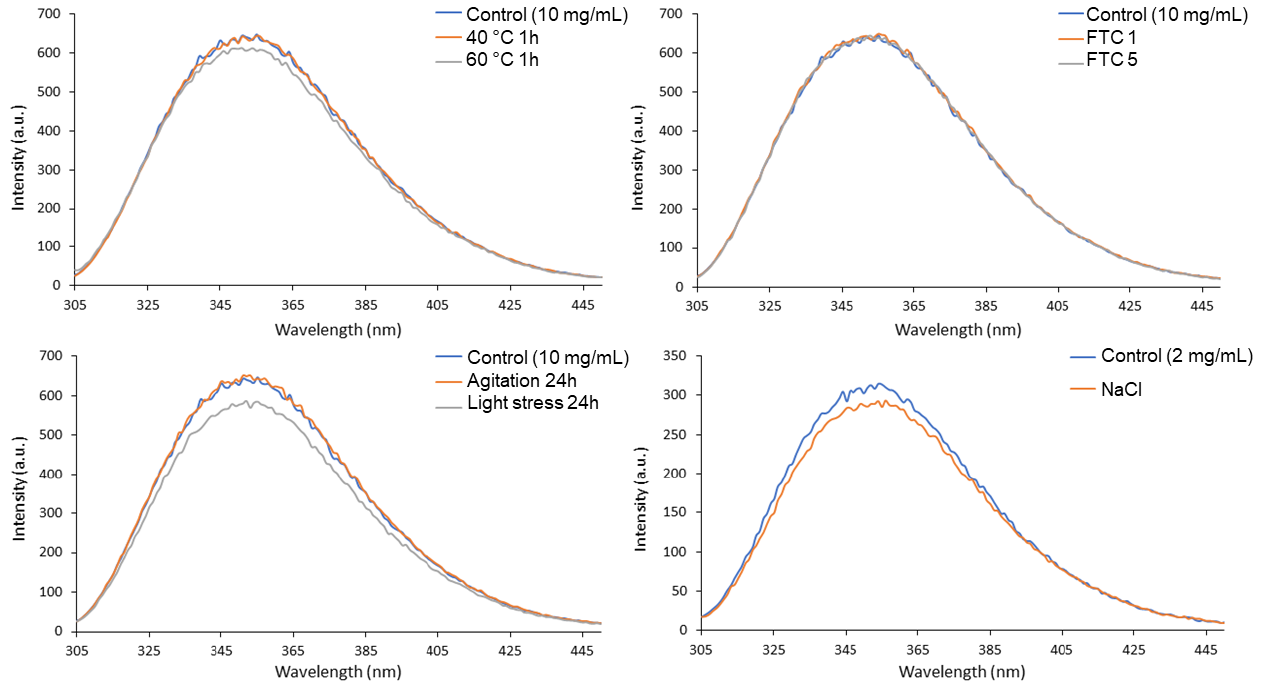
Figure 2. Nivolumab stress studies by IT-FS. Table 3. Nivolumab tertiary structure assessed using the C.M. of the IT-FS spectrum. Sample Stress